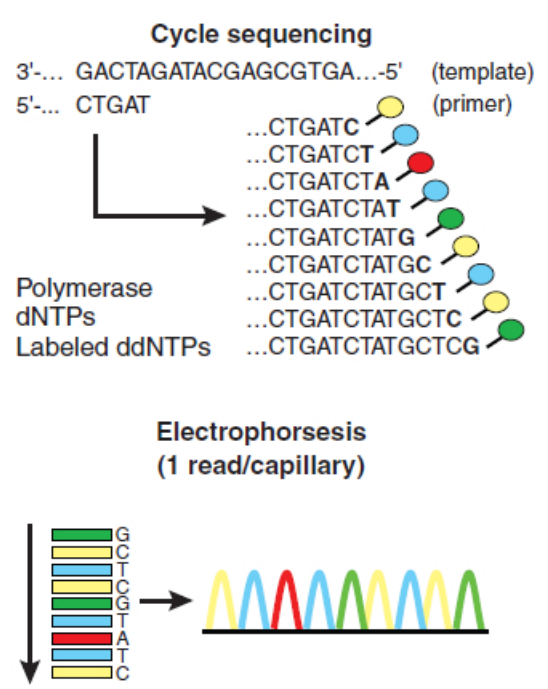
Figure 1. Sanger-based sequencing chemistry. In each sequencing reaction cycle, the amplified product is terminated by the incorporation of fluorescently-labelled dideoxynucleotides (represented by yellow, blue, red and green circles), which generates a ladder of differently-sized products. These products are subjected to high-resolution electrophoretic separation, and the four-colour detection system translates it to sequencing traces. The image is reproduced with permission from